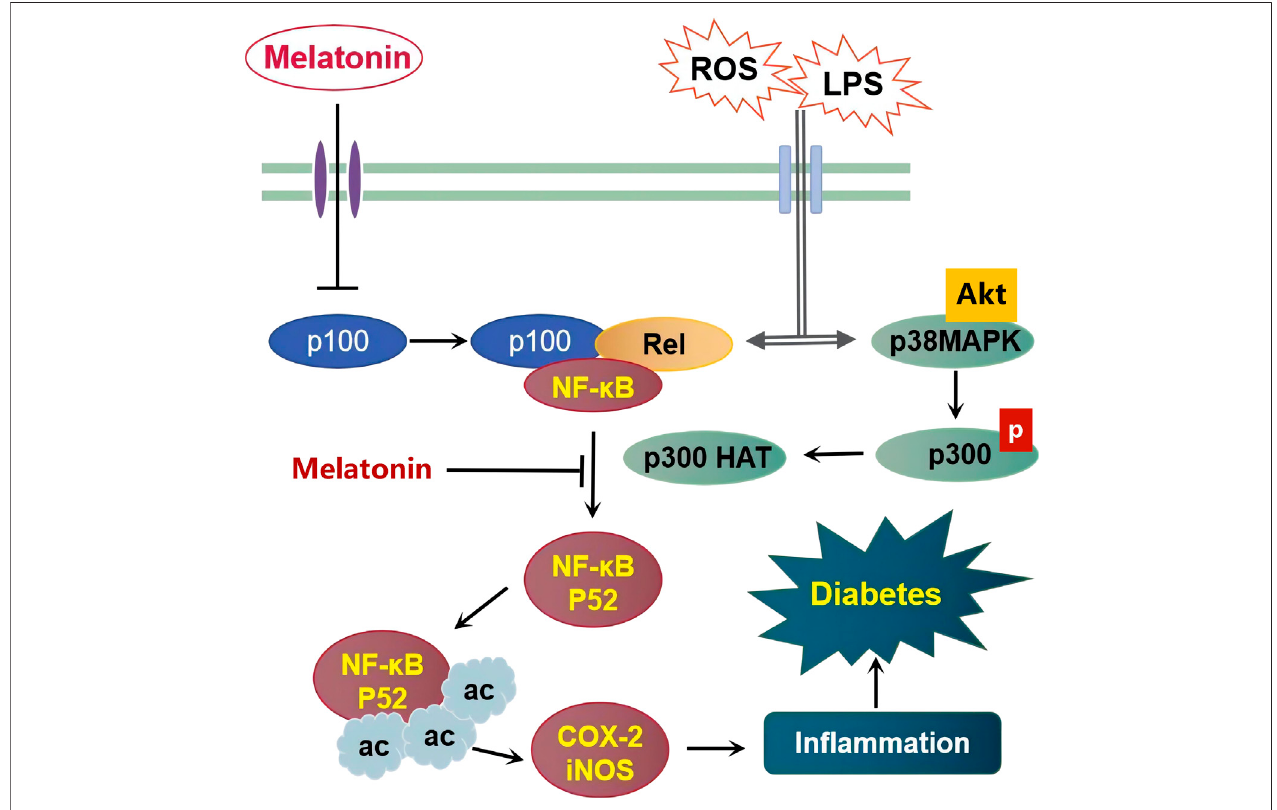
FIGURE 1 | Schematic representation of the proposed mechanism underlying melatonin ’ s protective effects on diabetes caused by in fl ammatory inducers including Lipopolysaccharides (LPS) and Reactive Oxygen Species (ROS).